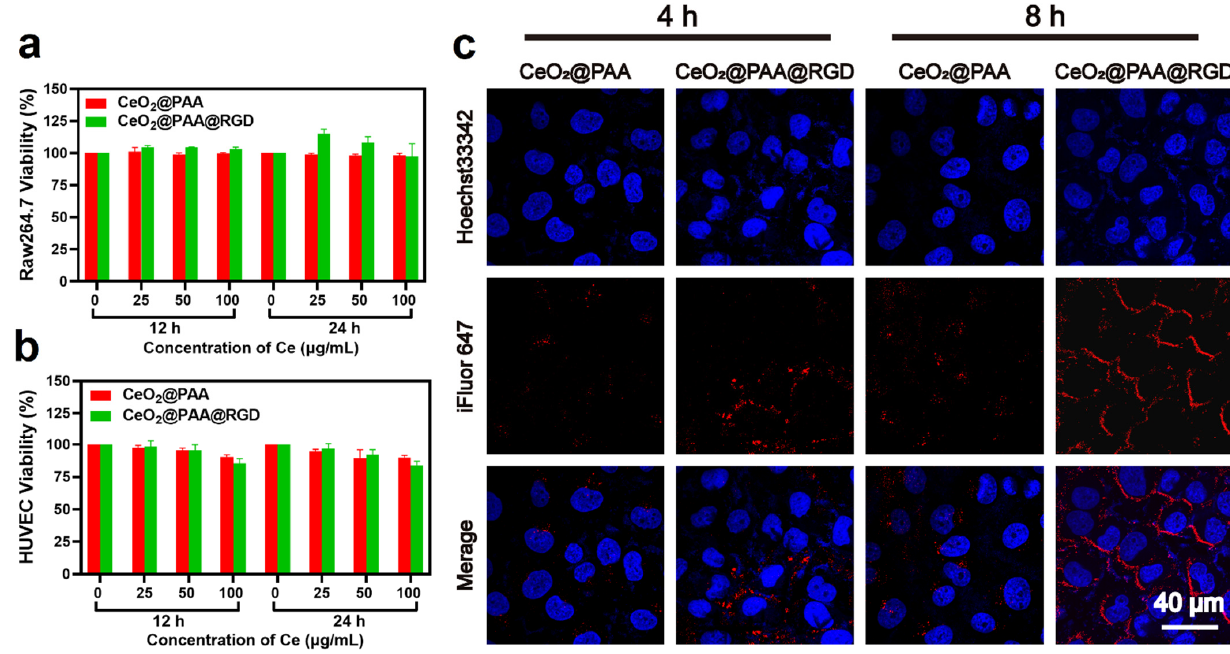
Figure 2. In vitro cytotoxicity and uptake assay s . ( a ) Cytotoxicity of CeO 2 @PAA